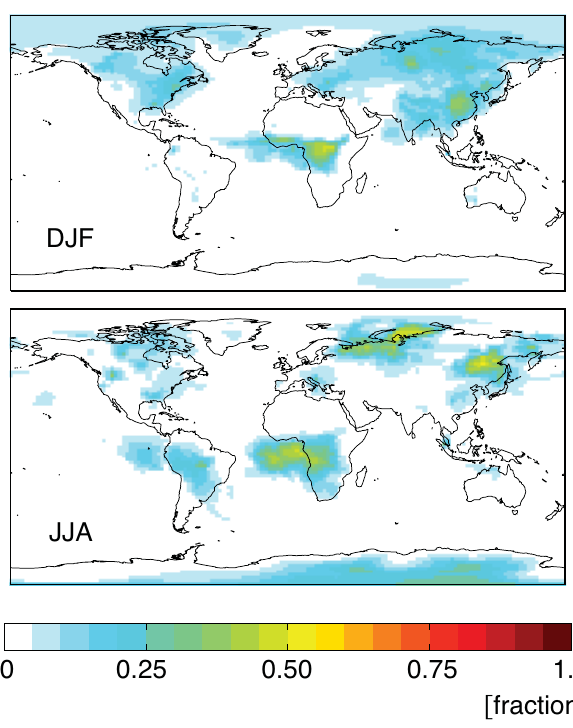
Fig. 3. Fraction of primary semivolatile material in aerosol phase as POA at the surface, seasonally averaged for year 2000. Fraction is simply the aerosol-phase SVOC concentrations (in ppb) divided by the total SVOC (gas+aerosol) concentration (in ppb). Simulations performed with GEOS-4 at 2 ◦ × 2 . 5 ◦ .